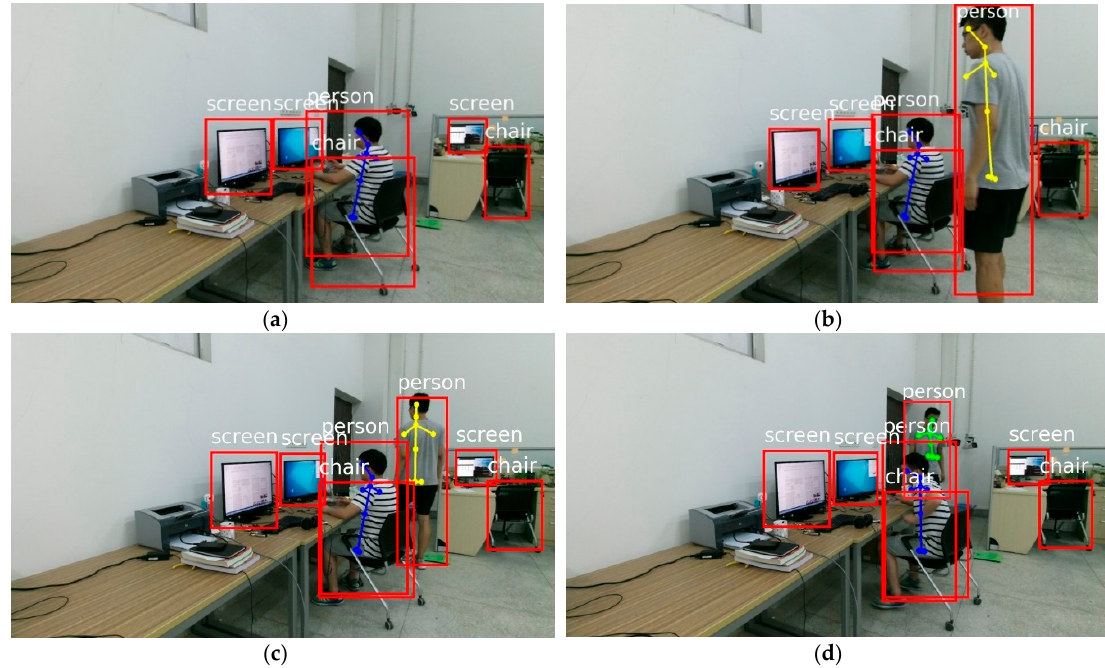
Figure 12. Unhealthy Sitting postures in complicated scenes are detected by our proposed method. In ( a – c ), when human body bends over and sitting on a chair, excessive cervical angle and excessive lumbar angle cause unhealthy sitting postures. In ( d ), when a person holds their head with hand on the desk, the distorted body results in unhealthy sitting posture.